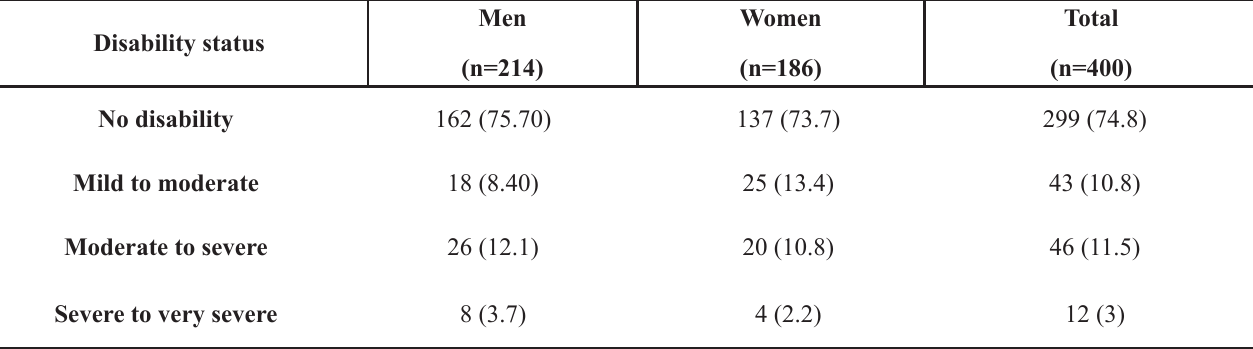
Table 3. Disability status in the elderly based on gender. Data are presented as n (%)